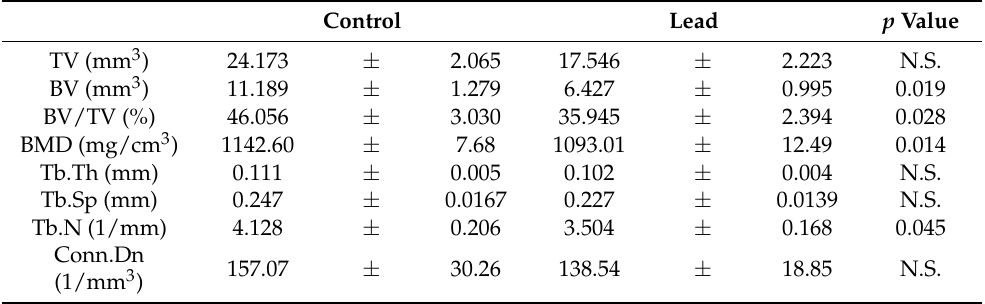
Table 1. Bone trabecular micro-architectural parameters obtained by micro-CT from rat mandibles in the chronic lead exposure ( n = 8) and control ( n = 5) groups. Values are expressed as means ± S.E.M. (N.S. = not